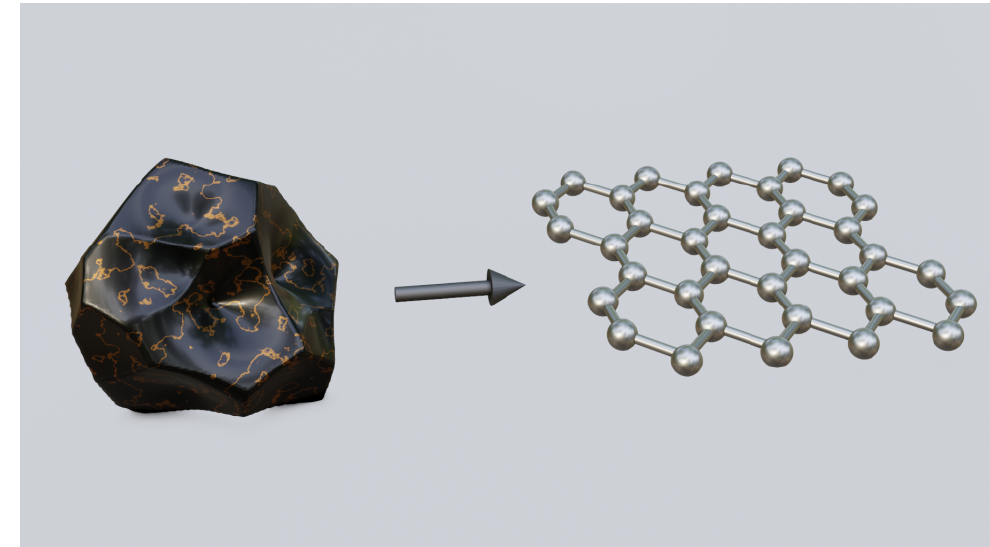
Figure 1. Illustration of Shungite rock and the graphene